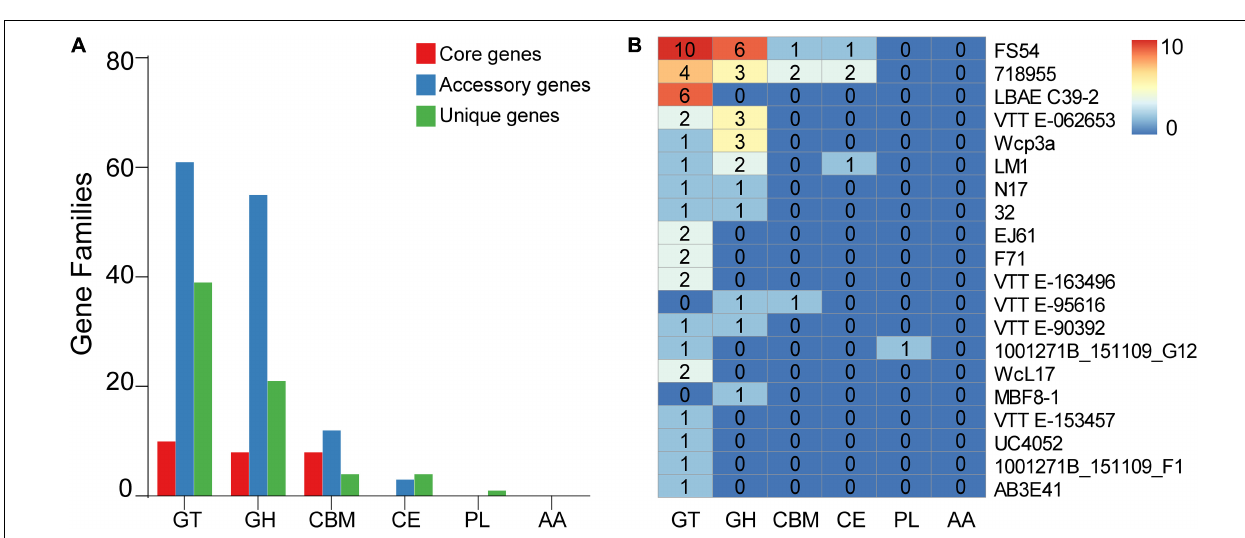
FIGURE 9 | Distribution of pan-genome of W. confusa on CAZymes. (A) The counts of orthologous genes assigned in the core genome, accessory genome, and unique genome on CAZymes. (B) The counts of unique genes of different W. confusa strains on